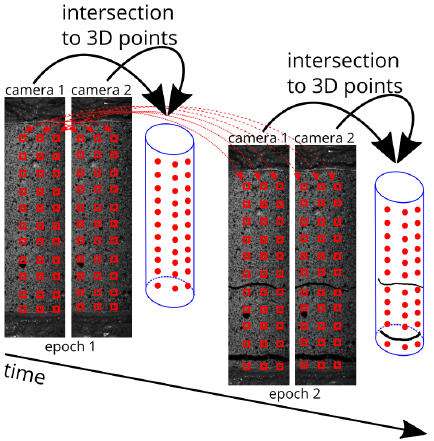
Figure 3. Matching in the stereo image pair and between epochs.